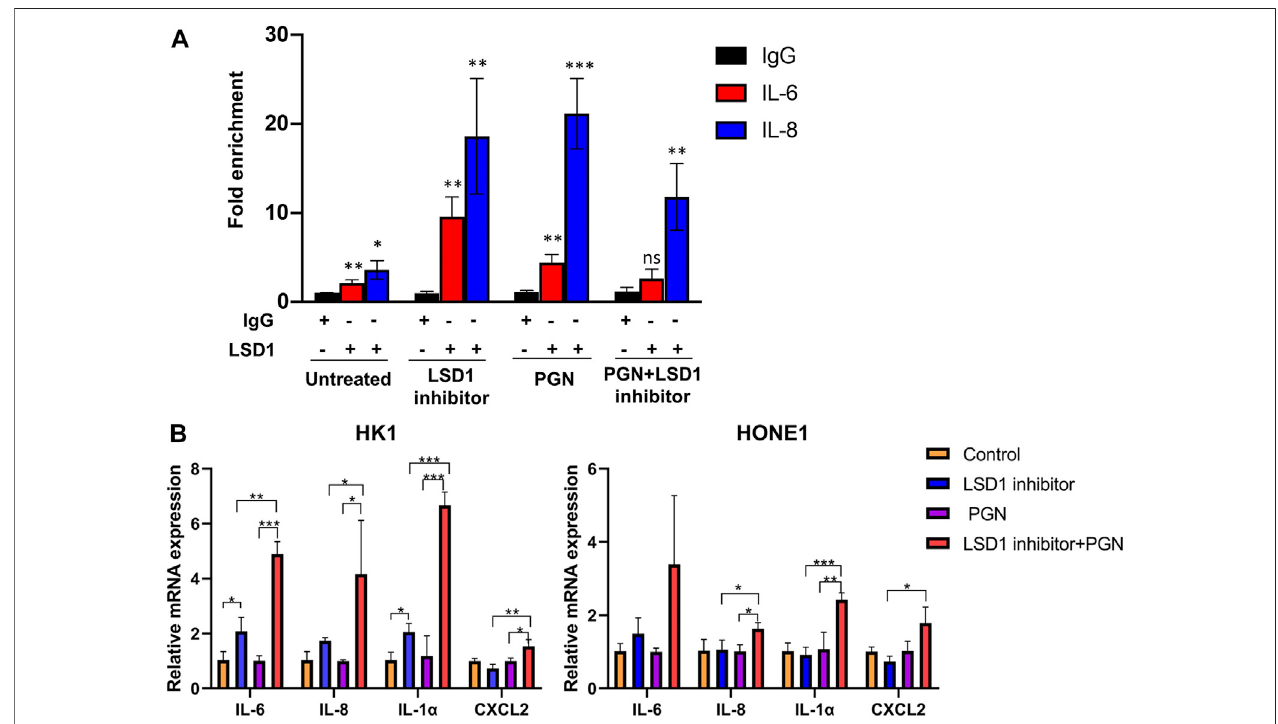
FIGURE 7 | LSD1 inhibits the transcription of pro-in fl ammatory genes in NPC-derived cell lines. (A) LSD1 ChIP analysis of IL6 and IL8 promoter occupancy in C666-1 cell. The bar graph represents fold enrichment in the LSD1 antibody binding to the IL6 and IL8 promoters after the treatment of NPC cell line C666-1 with LSD1inhibitorat6 nM,PGNat1 µg/ml,ortogetherovernight,inrelationtoIgGbinding. (B) Real-timeRT-qPCRanalysisofproin fl ammatorygeneexpressioninHK1and HONE1 cells before and after the treatment with LSD1 inhibitor overnight and followed by stimulation with PGN for two hours * p < 0.05; ** p < 0.01; *** p < 0.001.